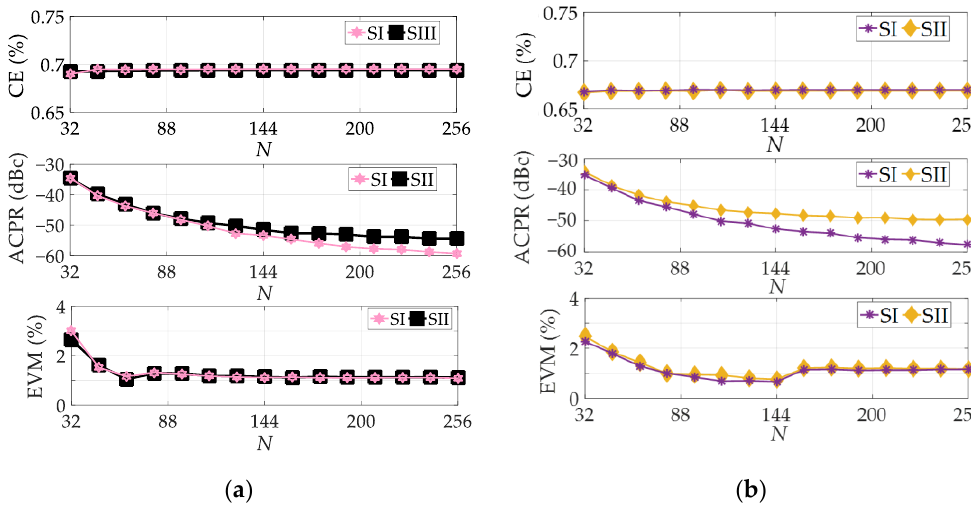
Figure 9. Comparison of the main modulation performance of SI and SII. ( l q = 512) ( a ) BW = 5 MHz;